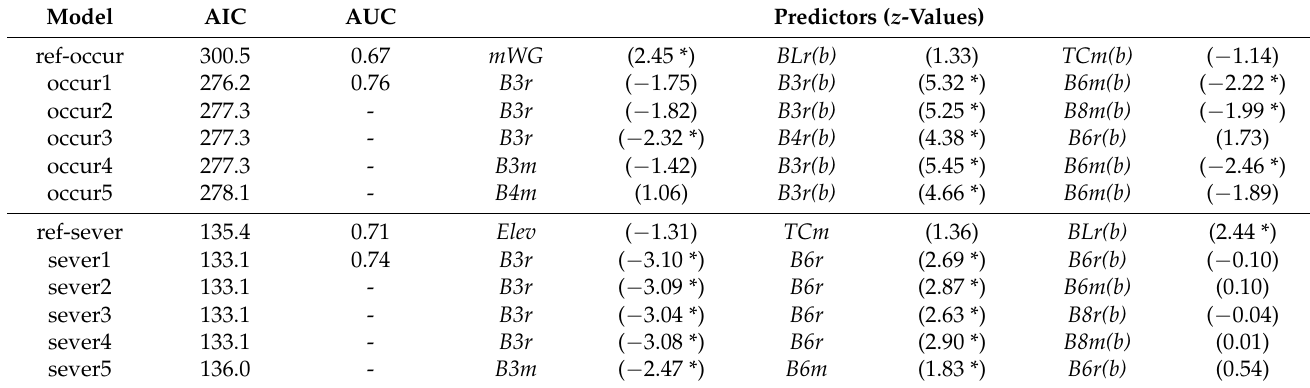
Table 3. Performance and selected predictors of the reference (ref-occur, ref-sever), and the five best S2 variable-based regression fits (occur, sever), ranked by the Akaike information criterion (AIC). Predictor importance and coefficient signs are indicated by z -values. Regressions ref-occur and occur refer to disturbance occurrence (NDG vs. DG0-1), while ref-sever and sever to binary disturbance